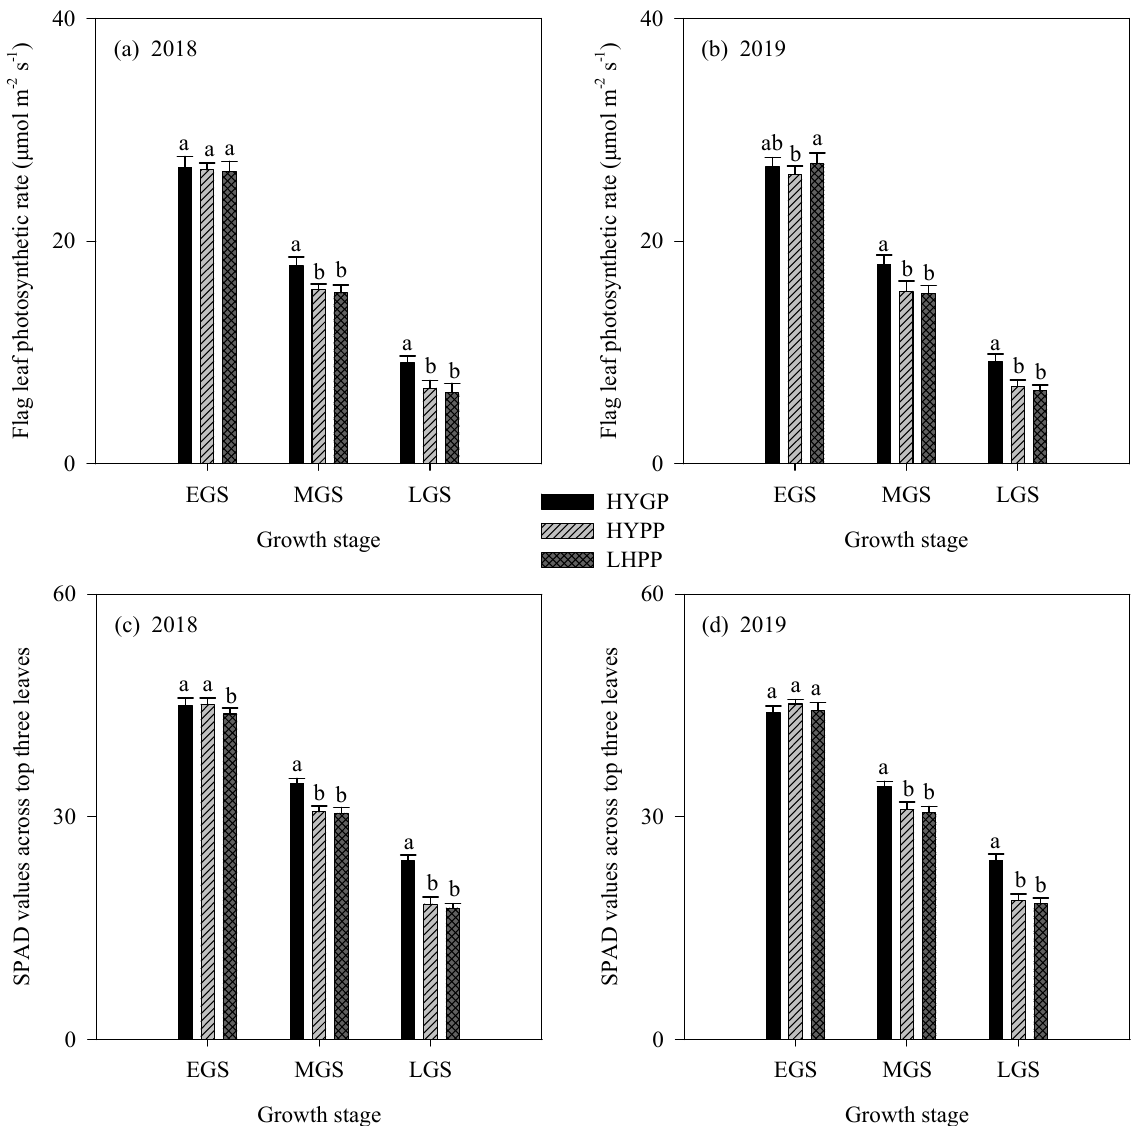
Figure 3. Flag leaf photosynthetic rate ( a , b ) and SPAD values across the top three leaves ( c , d ) after the heading of rice cultivar types. HYGP, high-yielding rice with good palatability; HYPP, high-yielding rice with poor palatability; LYGP, low-yielding rice with good palatability; EGS, early grain-filling stage; MGS, middle grain-filling stage; LGS, late grain-filling stage. Different lowercase letters in the same growth stage above the histogram indicate statistical significance at the p < 0.05